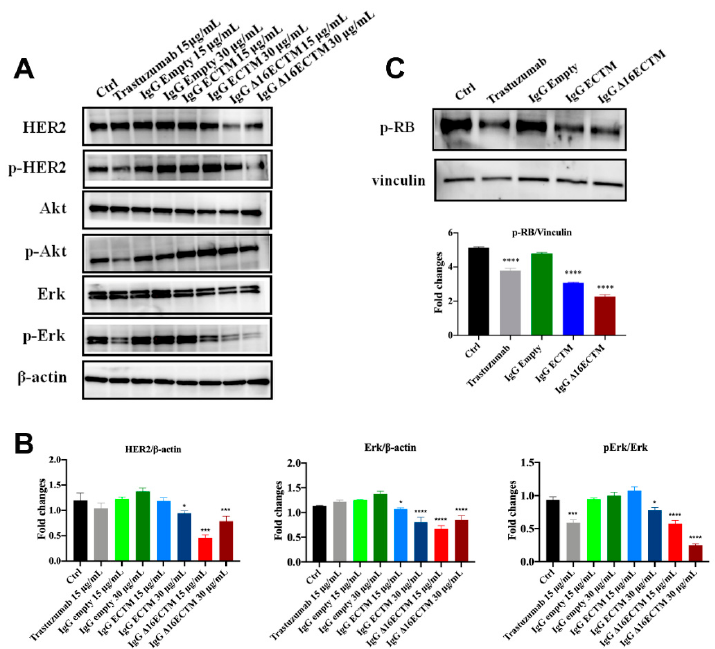
Figure 6. IgG purified from ECTM- and Δ 16ECTM-immune sera impaired ERK activation in BT-474 BC cells. ( A ). Representative Western blot analysis of HER2 downstream signaling pathways in BT- 474 cells, treated or not with trastuzumab or control-IgG or immune-IgG at the indicated concentra- tions for 8 h. Expression level of HER2, pHER2, AKT, pAKT, ERK, pERK was analyzed. Equal amounts of protein (20 µg) were loaded and β -actin was used as loading control. Data are repre- sentative of a typical experiment repeated three times with similar results. ( B ). Densitometric quan- tification of HER2 and ERK expression, normalized on β -actin, and of pERK/ERK from three inde- pendent experiments were shown; one-way ANOVA test followed by Tukey’s multiple comparison test (* p ≤ 0.05; *** p ≤ 0.001; **** p ≤ 0.0001: IgG ECTM or IgG Δ 16ECTM vs. IgG empty; trastuzumab vs. control). ( C ). IgG purified from ECTM- and Δ 16ECTM-immune sera reduced the levels of phos- phorylated RB in BT-474 cells. Upper panel: representative Western blot analysis of phosphorylated RB (Ser 780) in BT-474 cells, treated or not with 15 µg/mL trastuzumab or control-IgG or immune- IgG (30 µg/mL) for 8 h. Equal amounts of protein (20 µg) were loaded and vinculin was used as a loading control. Data are representative of a typical experiment repeated three times with similar results. Lower panel: densitometric quantification of phosphorylated RB expression, normalized on vinculin, was shown; one-way ANOVA test followed by Tukey’s multiple comparison test **** p ≤ 0.0001: IgG ECTM or IgG Δ 16ECTM vs. IgG empty; trastuzumab vs. control. The original western blot data can be found in Supplementary Materials File S1 (pages 1–3).